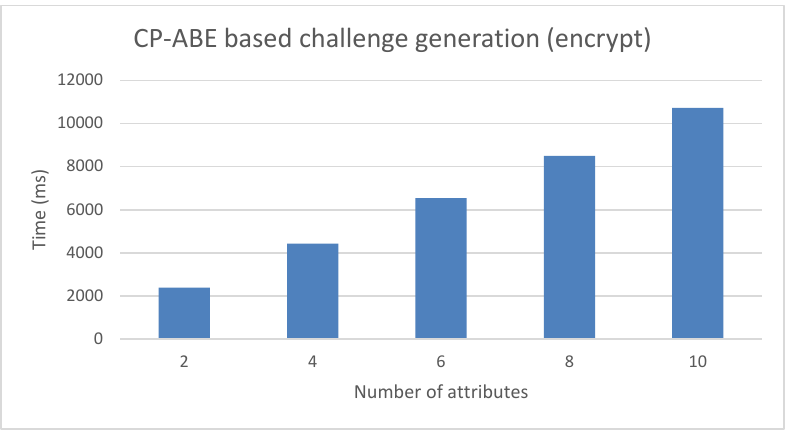
Figure 8. CP-ABE based Anonymous DCapBAC. Challenge generation performance.